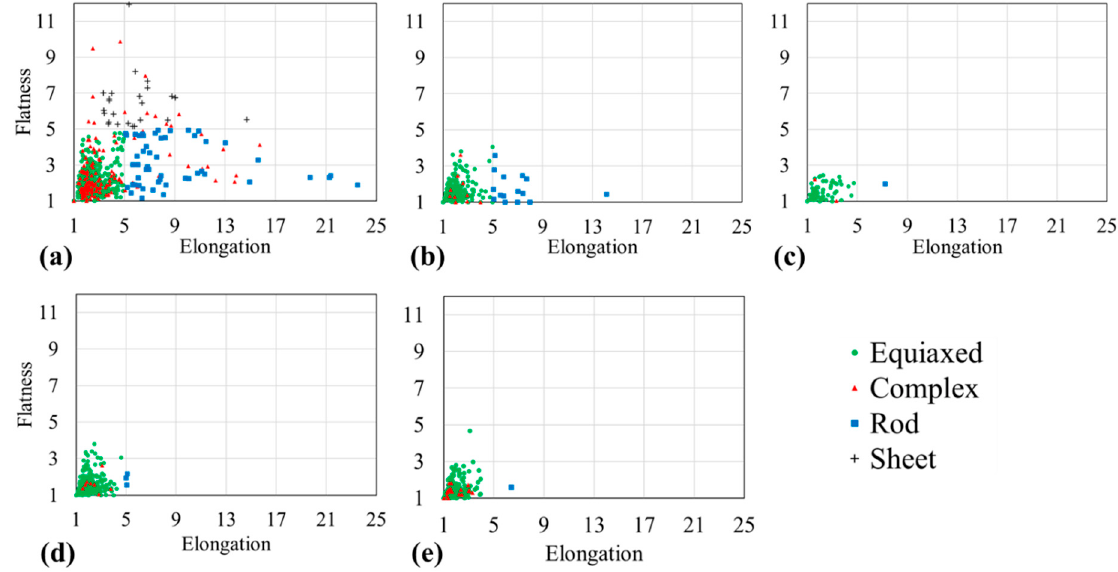
Figure 8. Flatness over elongation for Sn-Bi alloys based on the segmented µ-XCT data. Morphology classes are equiaxed (green), complex (red), rod (blue), sheet (grey). ( a ) Sn-20 wt.% Bi ( b ) Sn-30 wt.% Bi ( c ) Sn-35 wt.% Bi ( d ) Sn-47 wt.% Bi ( e ) Sn-58 wt.% Bi.